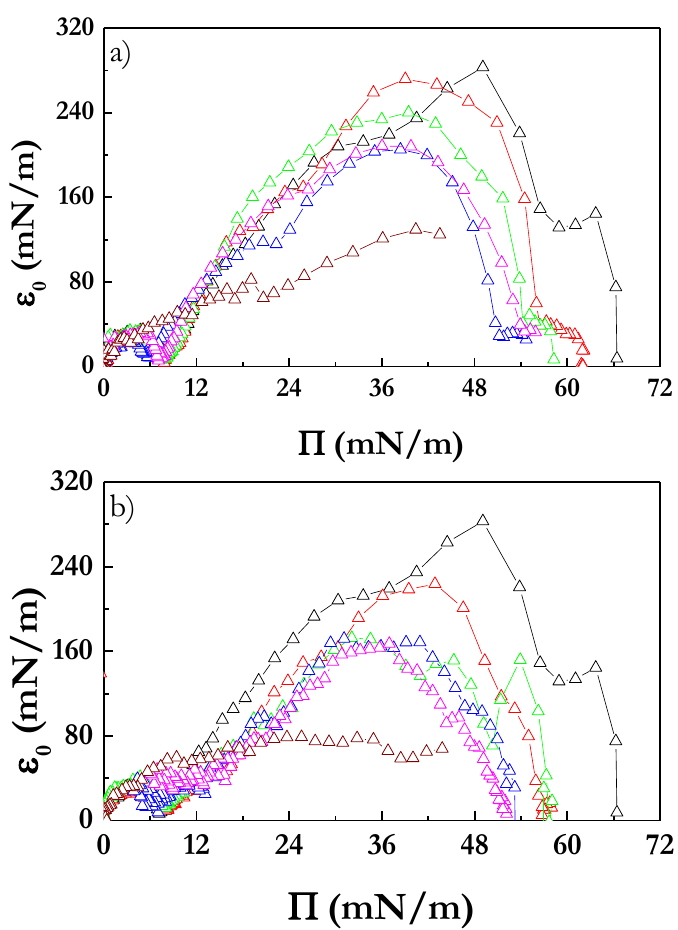
Figure 4. Quasi-static dilational elasticity ε 0 dependences on the surface pressure Π for DPPC Langmuir monolayer upon the incorporation of different weight fraction of particles at the interface ( x p ): CB ( a ) and SiO 2 ( b ). Each curve corresponds to DPPC monolayers with a different weight fraction of particles at the interface ( x p ): (Δ) 0.00, (Δ) 0.10, (Δ) 0.33, (Δ) 0.75, (Δ) 0.90 and (Δ) 1.00. Notice that the lines are guides for the eyes.